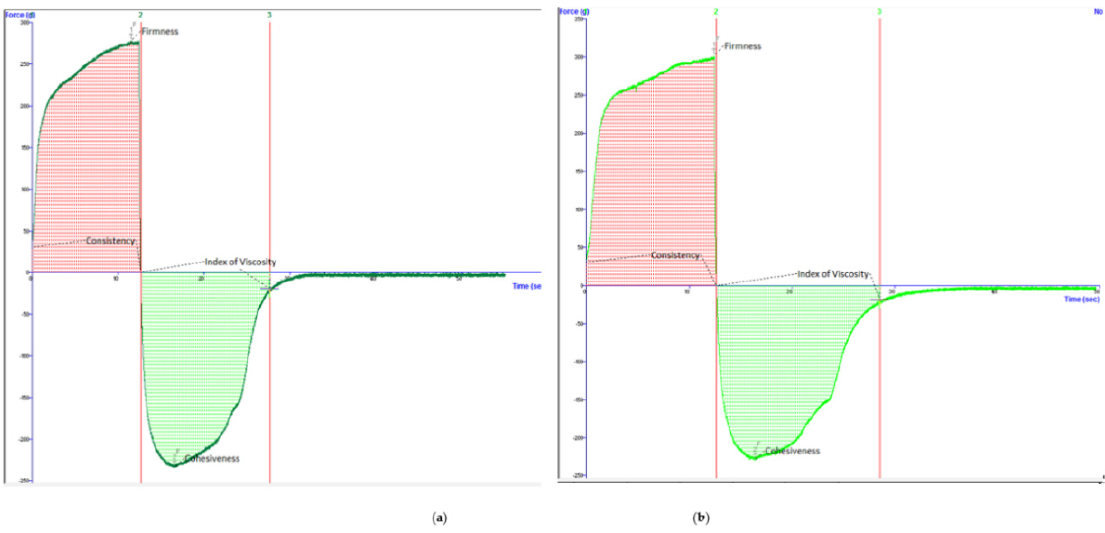
Figure 3. Texture analyses for formula base ( a ) initial and ( b ) after thermal shock.